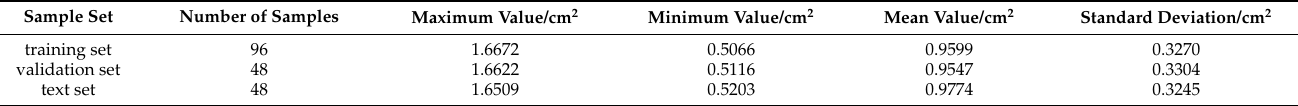
Table 1. Area of apple bruises.